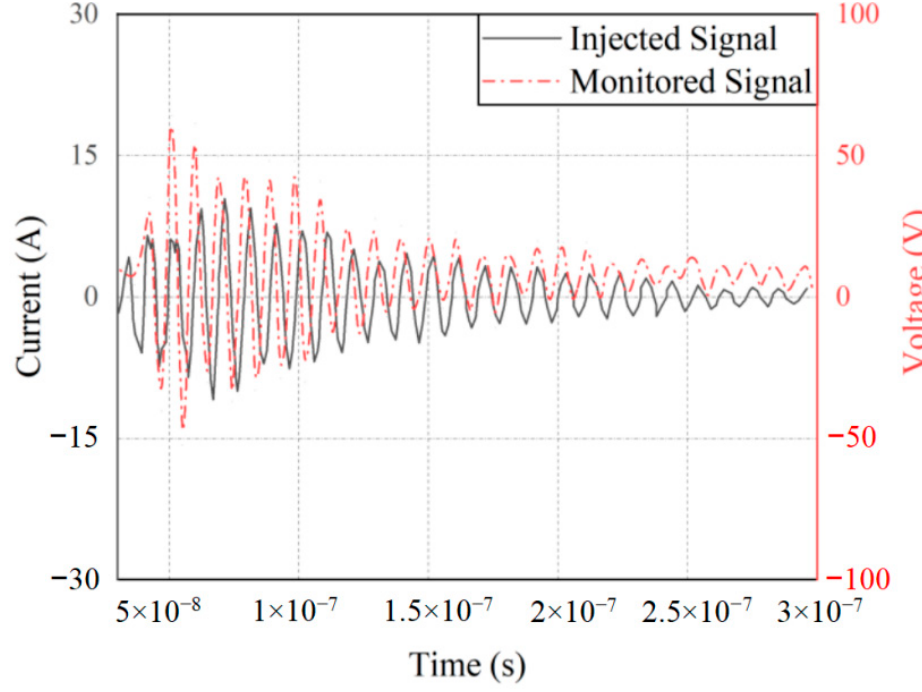
Figure 8. The coupling signal of the monitoring port. Table 2. The parameters of A and B .